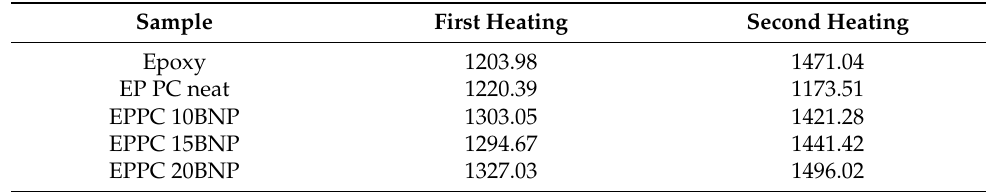
Table 1. Storage modulus G (cid:48) at 25 ◦ C of all composites in the first and second